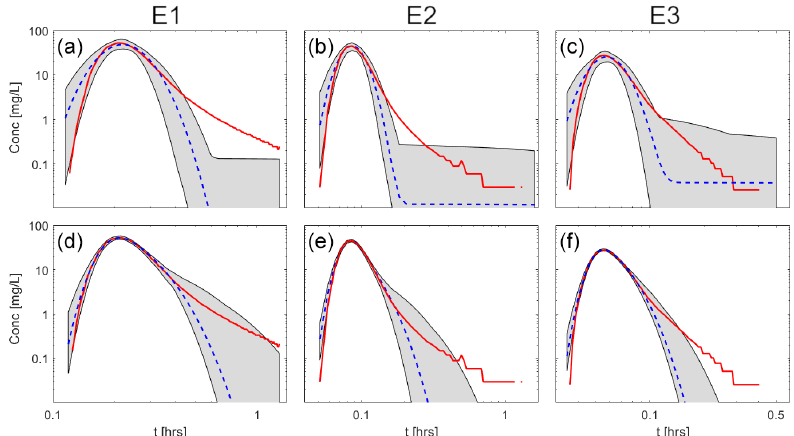
Figure B1. Observed BTC (red line) together with the grey area comprised between the top 100 simulated BTCs and the best-fitting BTC (blue dashed line) for (a, d) E1, (b, e) E2, and (c, f) E3. Results are reported for the first (a–c) and last (d–f) TSM iterations.